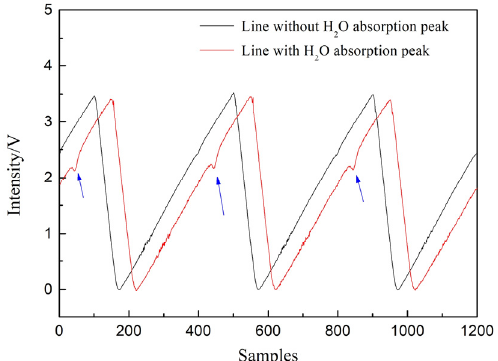
Figure 3. Laser signal of high frequency wavelength scanning.